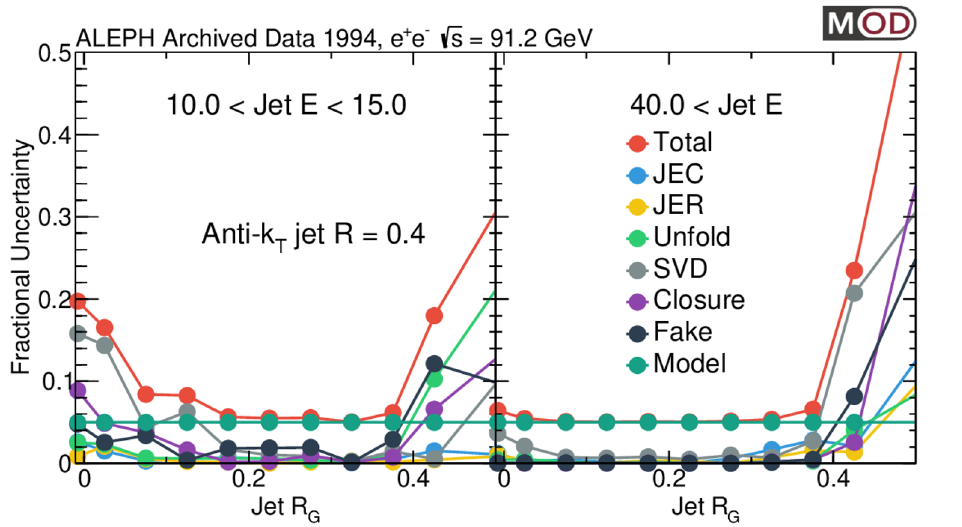
Figure 9 . Summary of the size of relative systematic uncertainty from different sources for R G , in bins of jet E from 10–15 GeV (left panel) to above 40 GeV (right